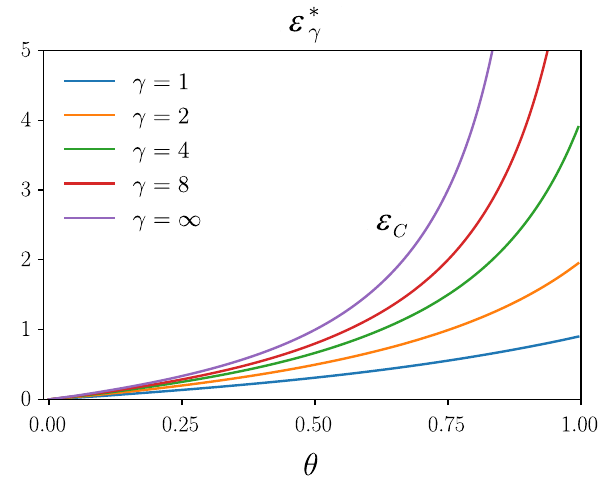
FIG. 4. Efficiency at maximum power. ϵ (cid:4) γ for γ ¼ 1 ; 2 ; 4 ; 8 ; ∞ , and R ¼ 10 , with γ ¼ ∞ corresponding to Carnot COP ( ϵ